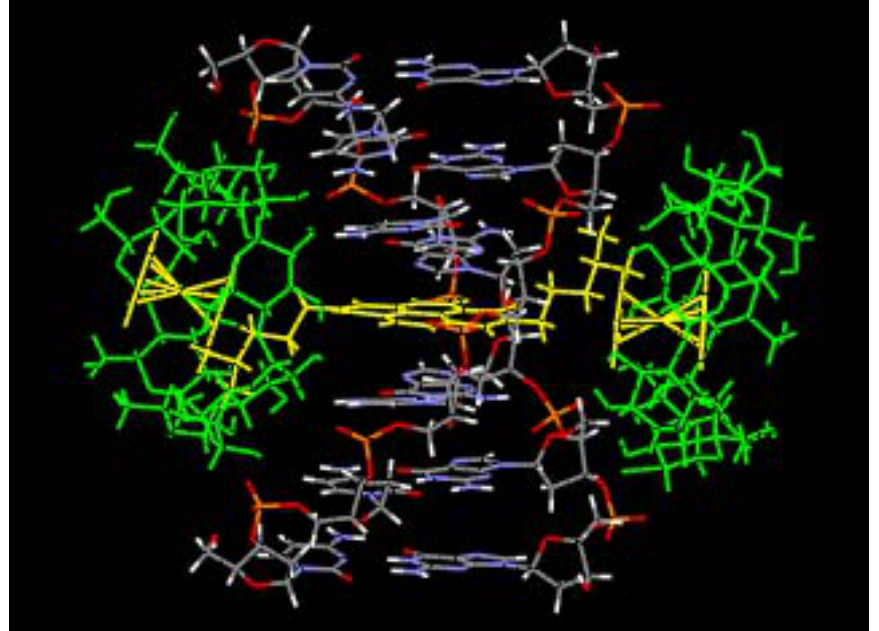
Figure 1. Stereo view of the supramolecular complex of β -CD and 1 threading- intercalated to d(AAATTT) 2